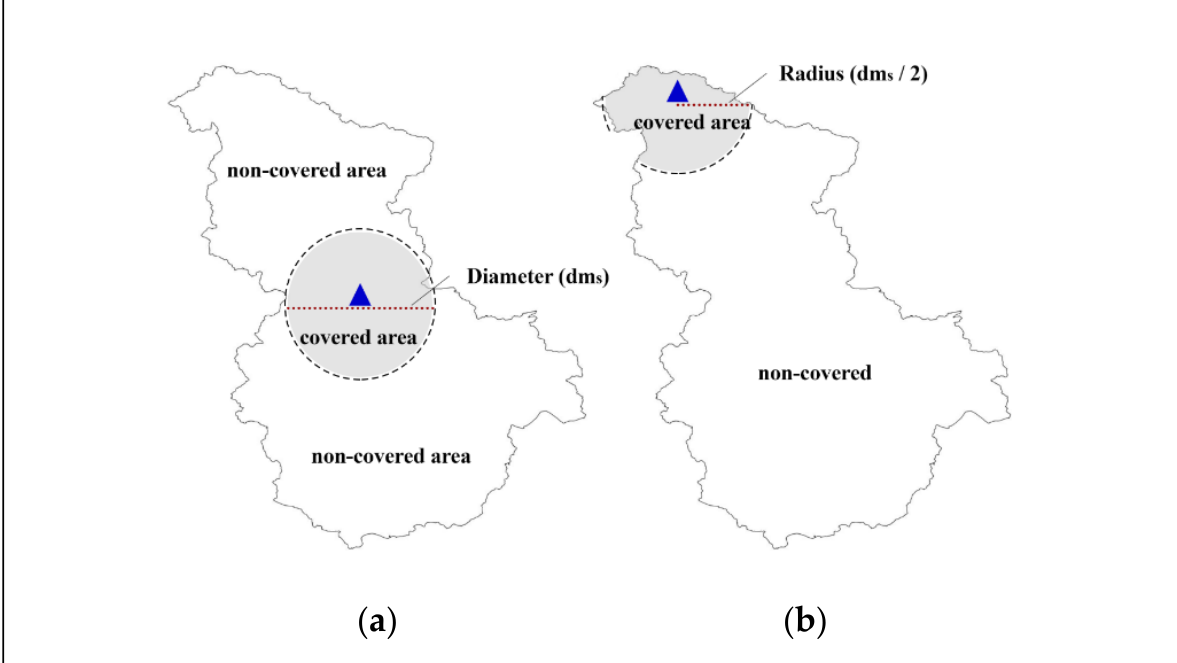
Figure 4. The ( a ) circle and ( b ) pie shapes indicate the covered areas by stations at the different positions on the map by determining a diameter length.